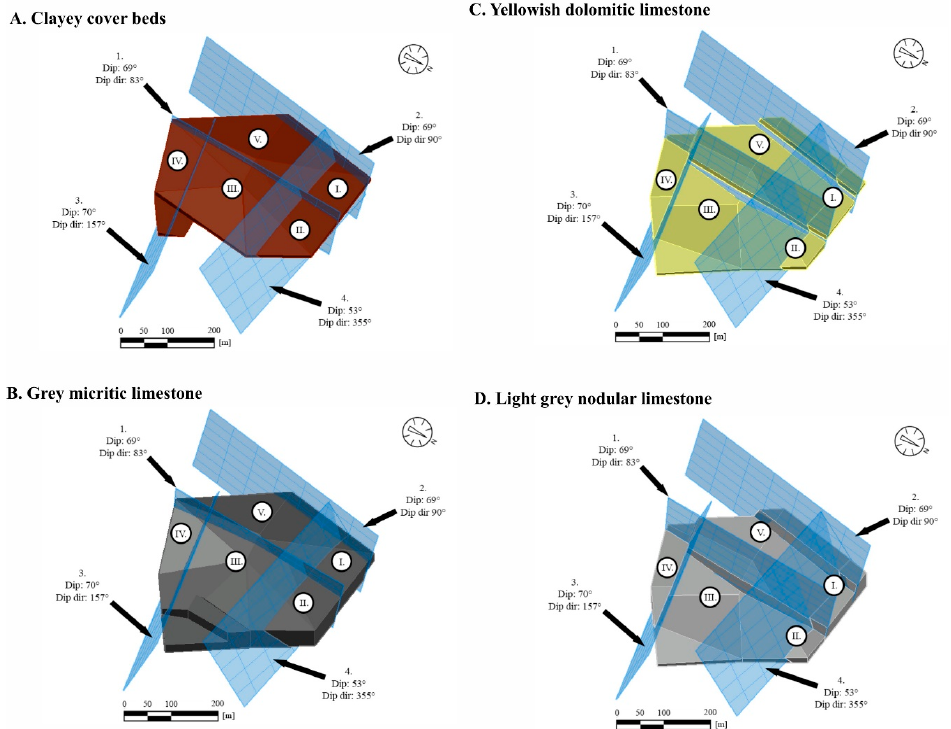
Figure 16. Simplified 3D model of the area with identified major faults and rock beds. The displacement of faults was compiled based on field data and core drillings. The figure also shows the five blocks (numbered by I–V) that are bordered by major faults and used for reserve calculations. For each lithological unit (A–D), a 3D model was generated showing the major fault systems, numbered 1–4, that delineates each block (Figure 17A–D).